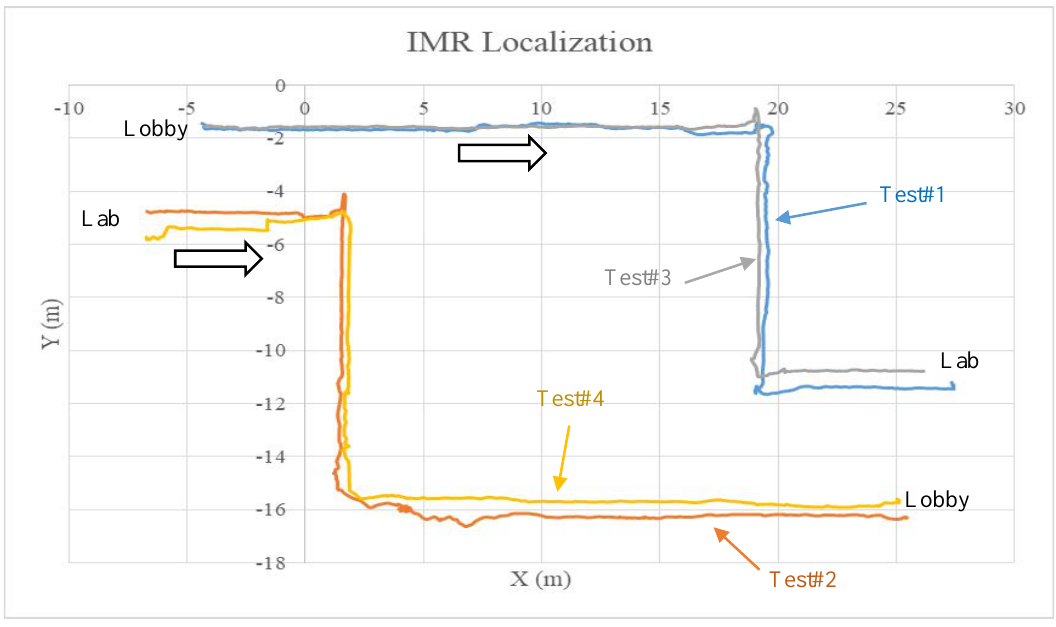
Figure 14. Active localization of IMR based on e-SLAM.